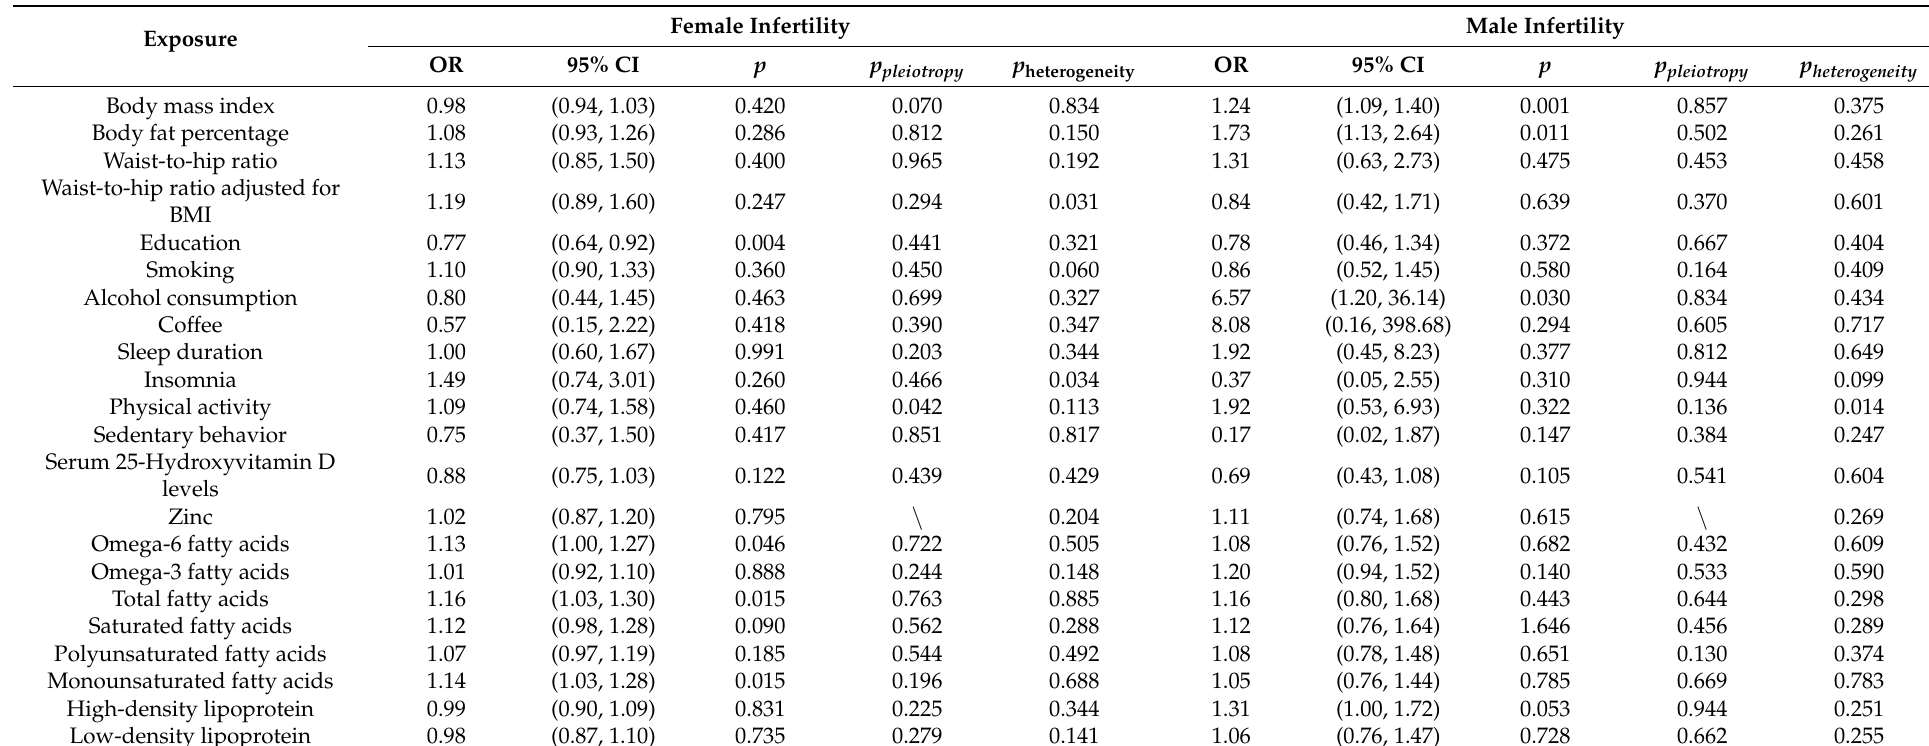
Table 3. Results of MR analysis between modifiable risk factors and